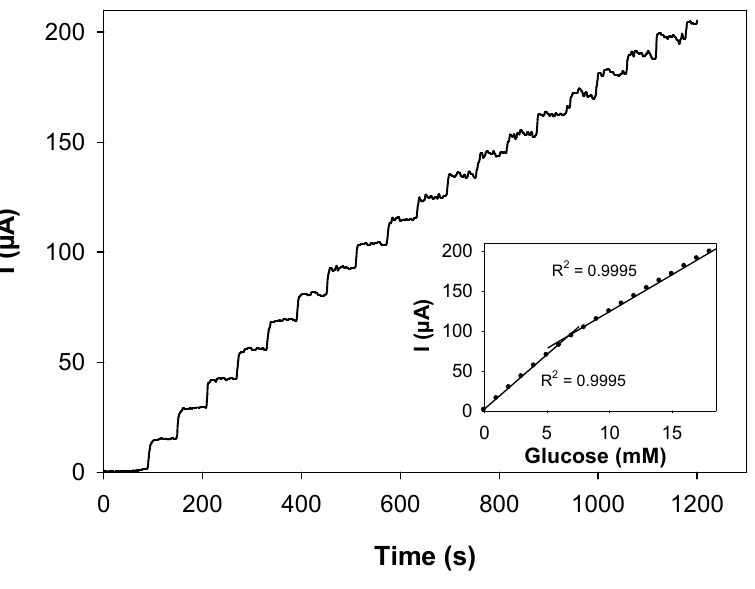
Figure 7. Amperometric response of the Au-MPTS-Pt towards successive additions of 1 mM glucose into a stirring solution of 0.1 M phosphate buffer (pH 7.4) at a constant potential of 0.4 V. Inset: Calibration curve of the Au-MPTS-Pt amperometric response of the glucose concentrations against the corresponding current generated. Sensitivity: 1 to 7 mM and 7 to 18 mM are 191.67 and 135.98 μA mM −1 cm −2 , respectively.